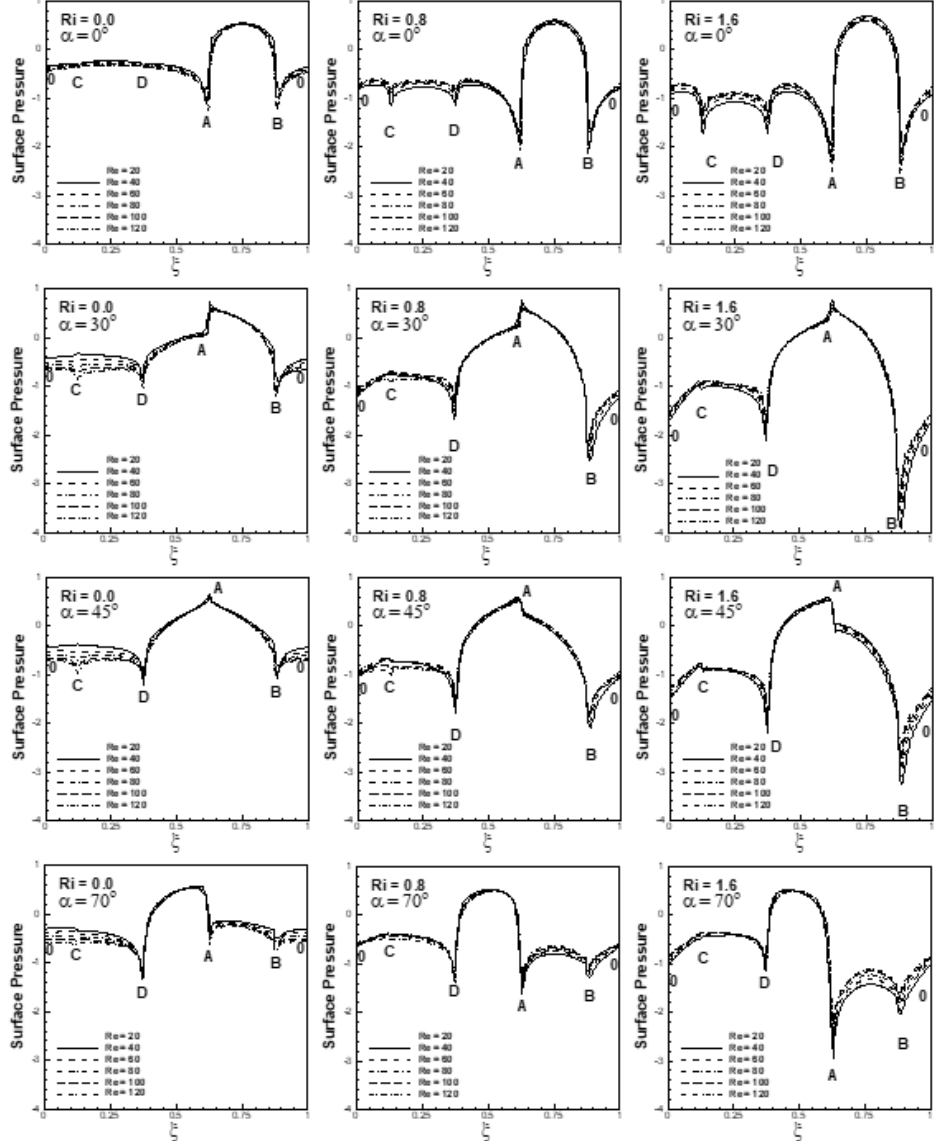
Figure 12. Variation of mean pressure along the surface ( ξ ) of the cylinder for the condition (20 ≤ Re ≤ 120, 0° ≤ α ≤ 70° at Ri = 0, 0.8, 1.6).